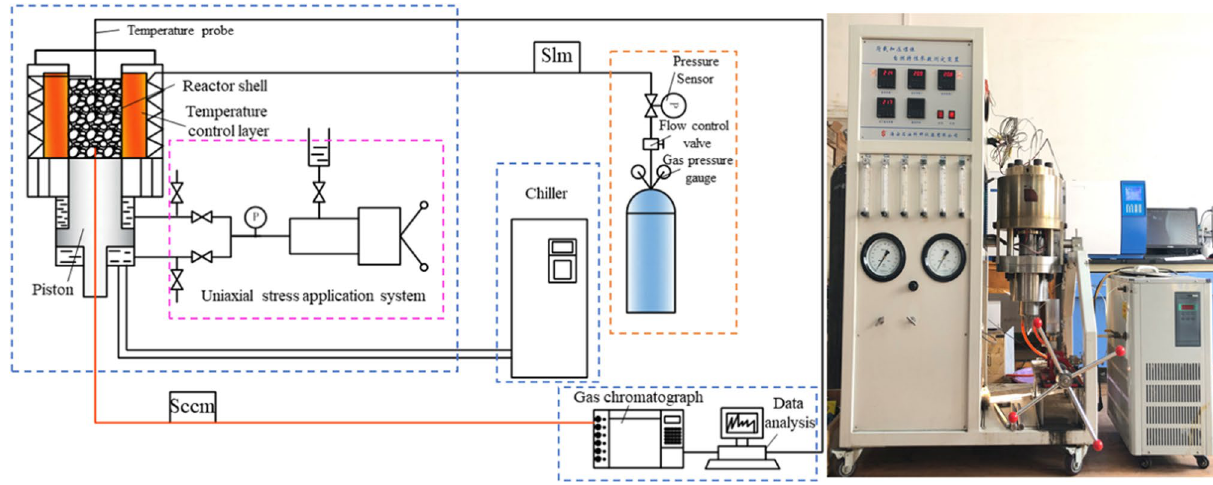
Fig. 1 UCTP experimental system and actual diagram Fig. 2 SEM photo of coal sam- ple pretreatment under uniaxial stress. a 0 MPa; b 2 MPa; c 4 MPa; d 6